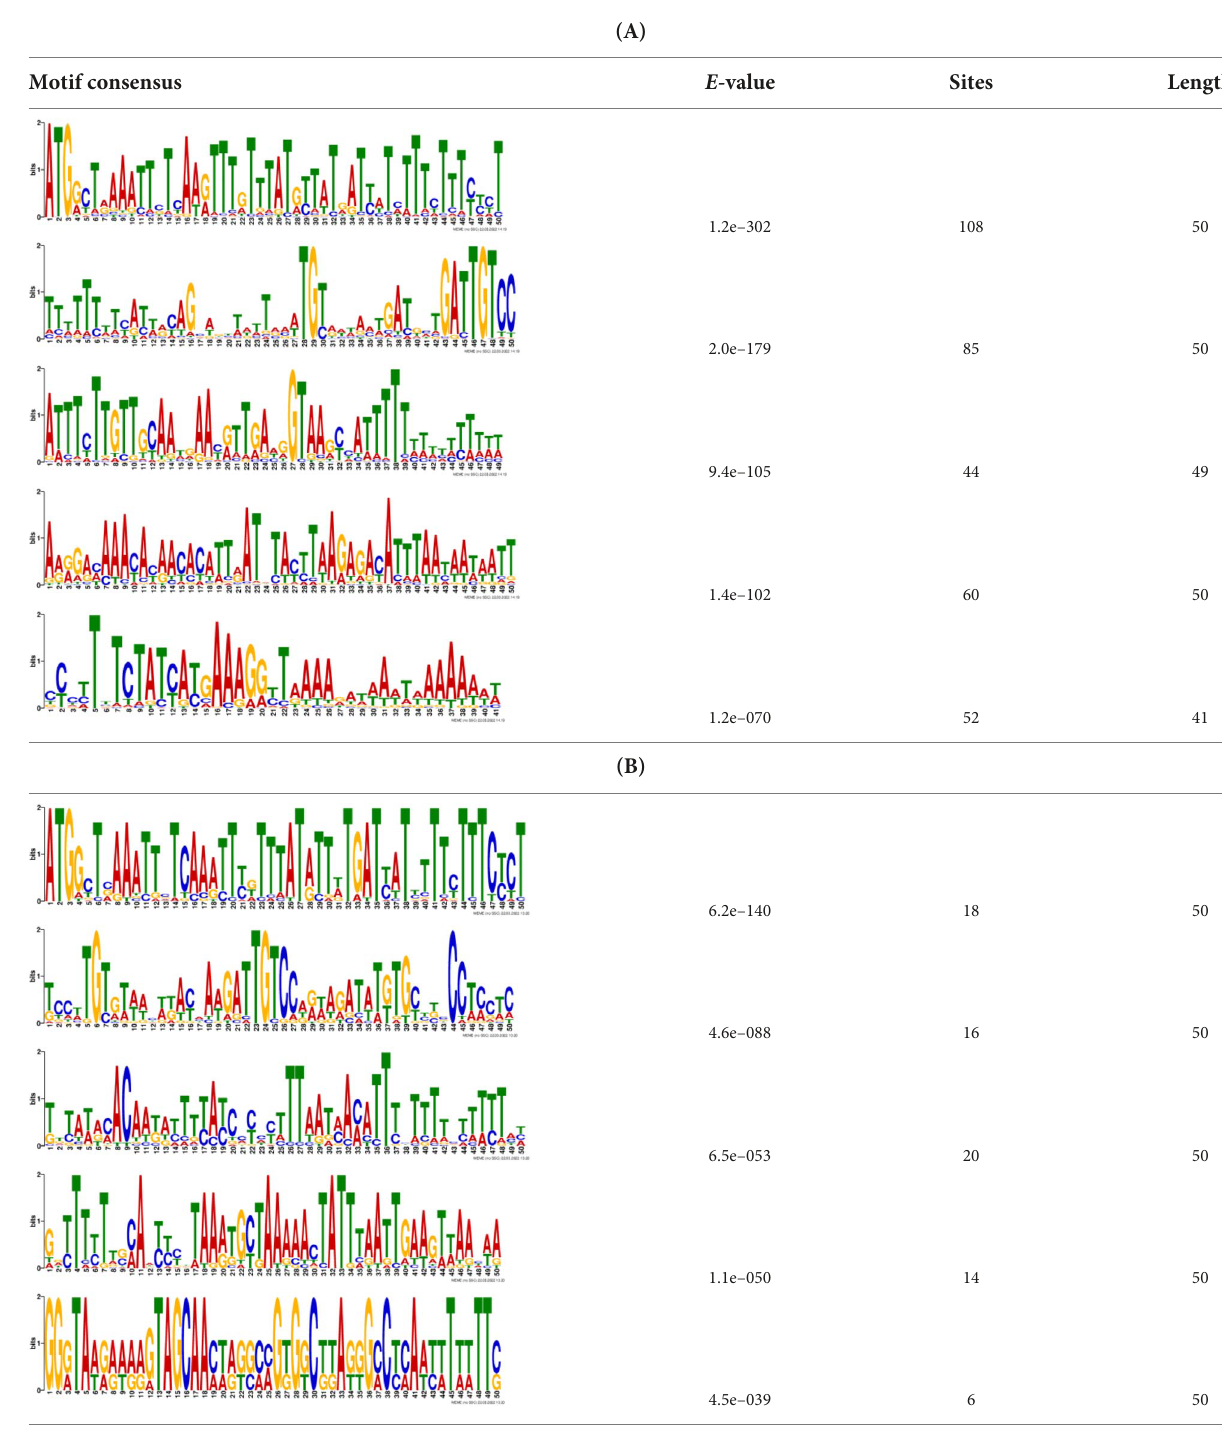
TABLE 4 (A) The conserved motifs found in the upstream regions of “early” NCR genes using the MEME tool. (B) The conserved motifs found in the upstream regions of “late” NCR genes using the MEME